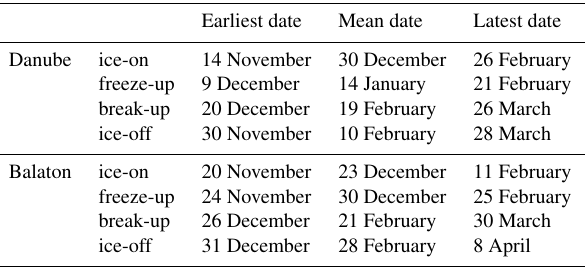
Table 3. Comparison of break-up and ice-off dates relating to the whole dataset (whole) and winter with ice cover (ice cover) on the Danube and Lake Balaton from 1885 to